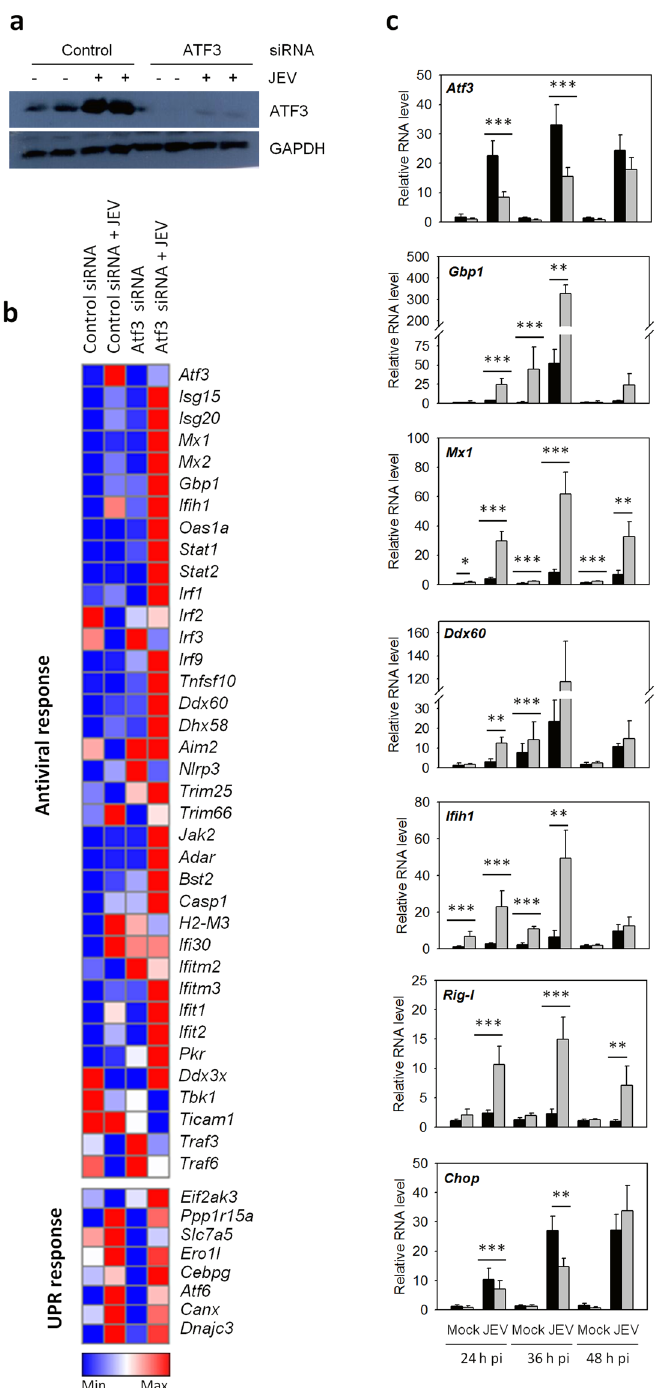
Figure 2. ATF3 acts as a negative regulator of the antiviral response. ( a ) Neuro2a cells were treated with either a control non-targeting siRNA or the Atf3 -specific siRNA for 48 h and then infected with JEV (MOI 5). Total proteins from the cell lysates harvested at 24 h pi were Western blotted to establish the ATF3 depletion. ( b ) Total RNA was isolated from the cells at 24 h pi and qRT PCR performed in triplicates to determine the relative transcript levels for various ISGs or members of UPR pathway. Mean values were used to create the heat map demonstrating the gene-expression profiles using the Gene-E software. ( c ) Neuro2a cells were treated with either a control non-targeting siRNA or the Atf3 -specific siRNA for 48 h and then infected with JEV (MOI 5) for different time points. The experiment was done in triplicates on three different occasions. Relative expression of various genes at different times pi was studied by qRT PCR performed in triplicates for each sample, and the mean is plotted. Transcript level in control siRNA-treated cells is shown by the black bar while that in the Atf3 siRNA- treated cells is shown by the gray bar. The Gapdh levels were used for normalization. The statistical significance of the difference between the data was established by Student’s t-test; * p < 0.05; ** p < 0.01; *** p <